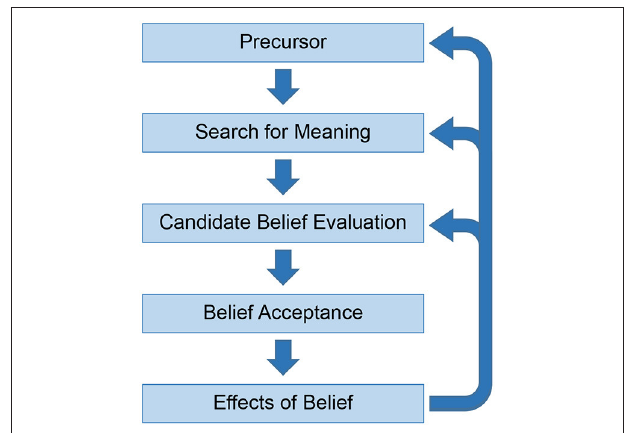
FIGURE 1 | Five stages of belief